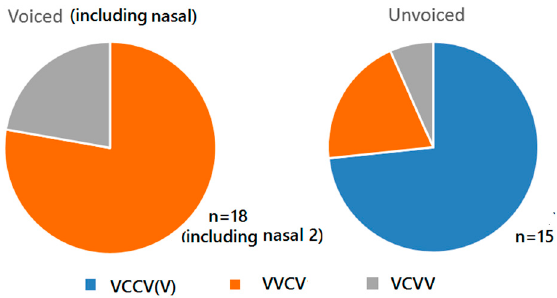
Figure 1. Phonological types of adjectives in Furumachi, Niigata: Watanabe data.